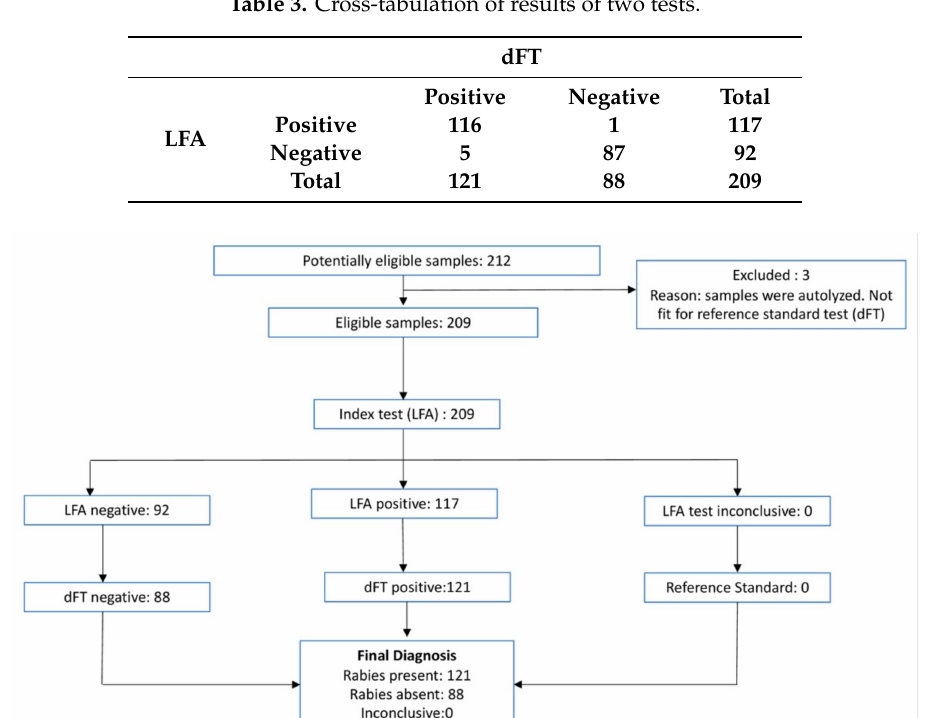
Table 3. Cross-tabulation of results of two tests.